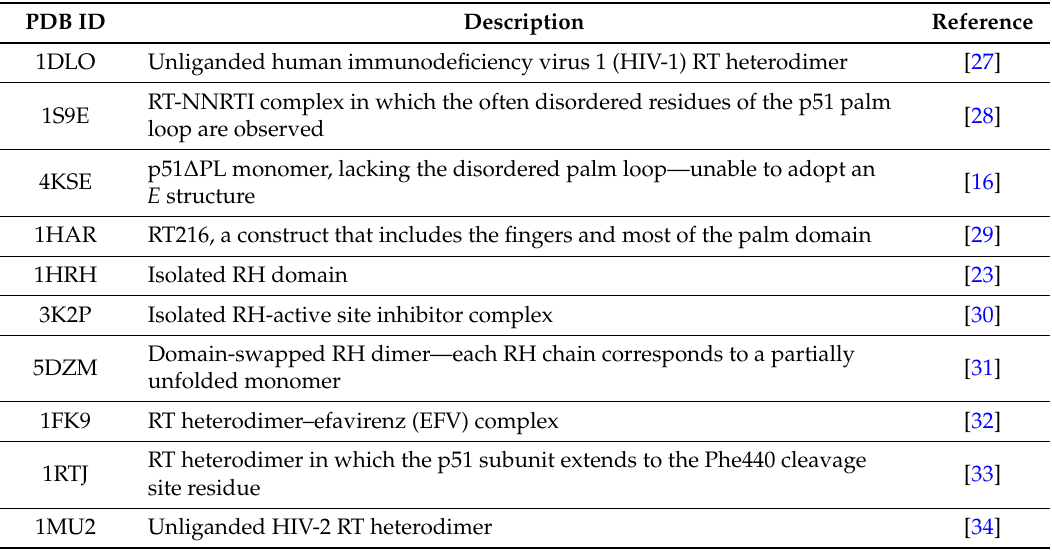
Table 2. Crystal structures